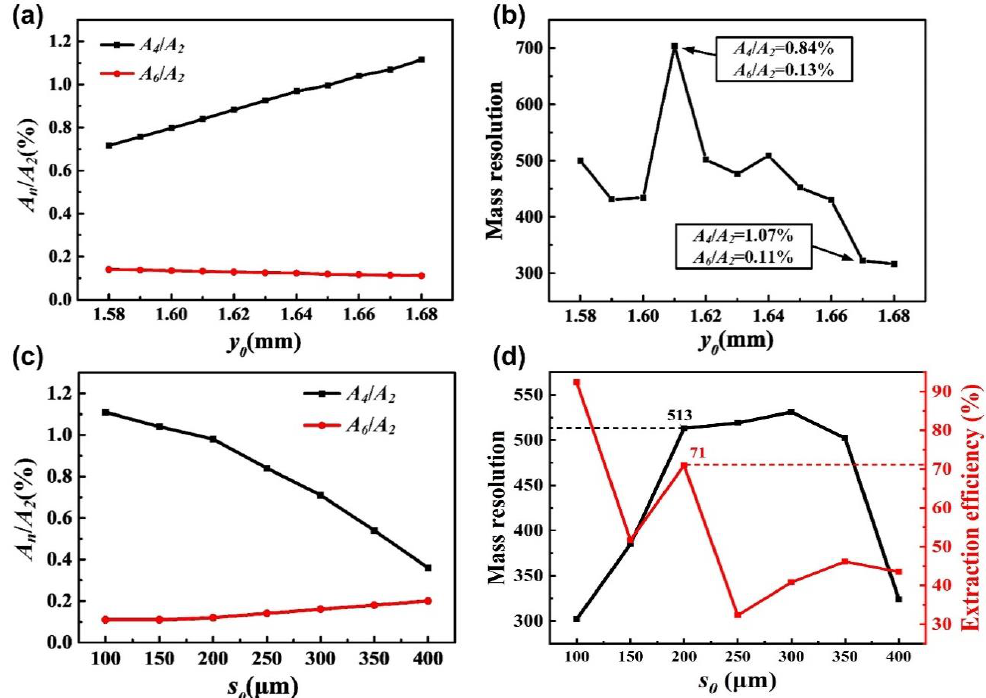
Figure 3. ( a ) Change in the internal electric field composition based on different y 0 . ( b ) Change in the mass resolution based on different y 0 . ( c ) Change in the internal electric field composition based on different s 0 . ( d ) Changes in the mass resolution and ion extraction efficiency based on different s 0 .